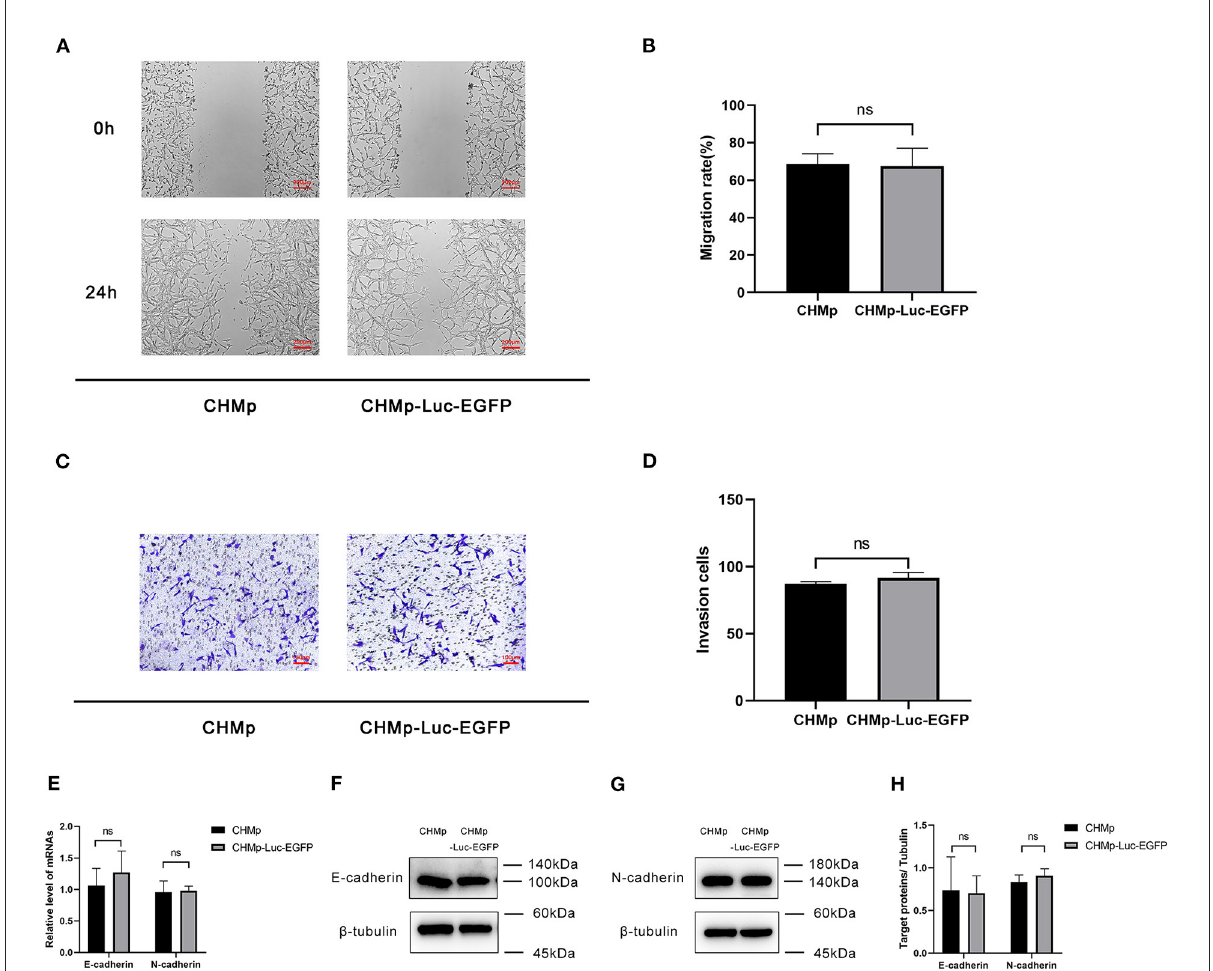
FIGURE2 In vitro metastasis of CHMp-Luc-EGFP cells and CHMp cells. (A,B) Wound-healing assay. Percent migration of CHMp cells and CHMp-Luc-EGFP cells were calculated, which were 68.74% ± 5.33% and 67.68% ± 9.37%, respectively. Magnification × 4; scale bar, 200 µ m. (C,D) Invasion assay. The number of invading cells was 87 ± 2 for CHMp compared with 92 ± 4 for CHMp-Luc-EGFP. Magnification × 10; scale bar, 100 µ m. (E) mRNA expression of E-cadherin and N-cadherin. (F–H) Protein expression of E-cadherin and N-cadherin. Data are the mean of three independent experiments, mean ± SD. Significance was determined using a two-tailed unpaired t -test. ns,